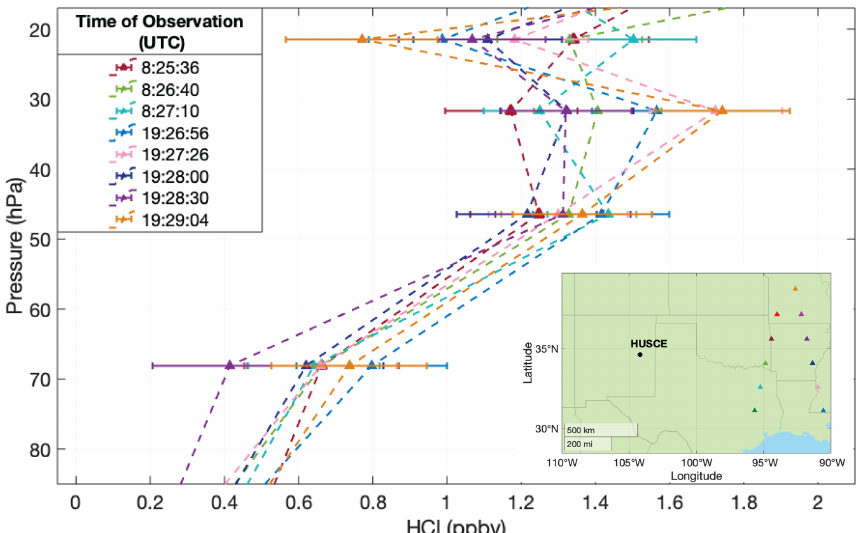
Figure 11. MLS observations of HCl made near HUSCE on 24 August 2018. Error bars indicate MLS-reported uncertainty. Dashed lines are for readability; they do not indicate known trends between the observations shown as colored triangles. Inset: locations of each MLS observation (colors are coordinated with the main